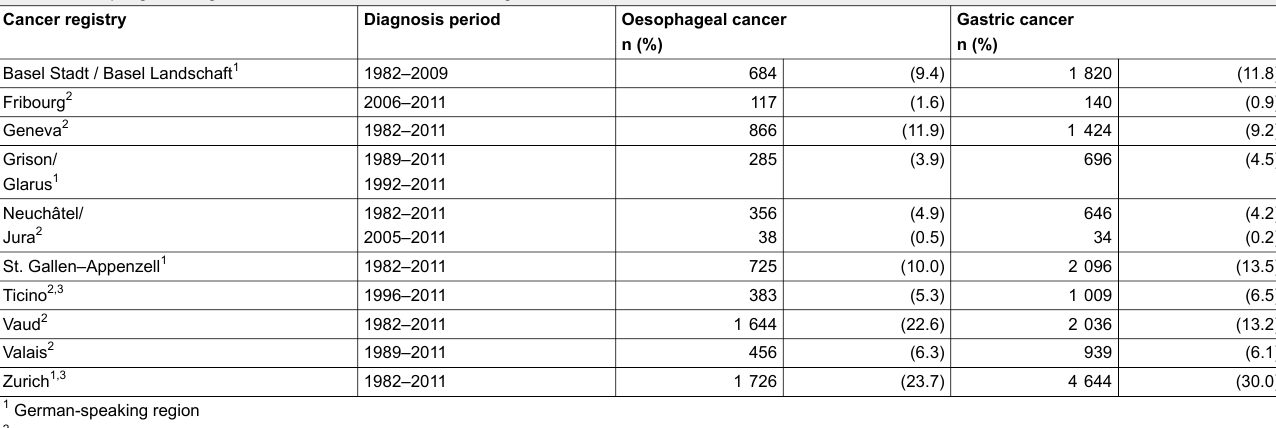
Gastric cancer n (%) n